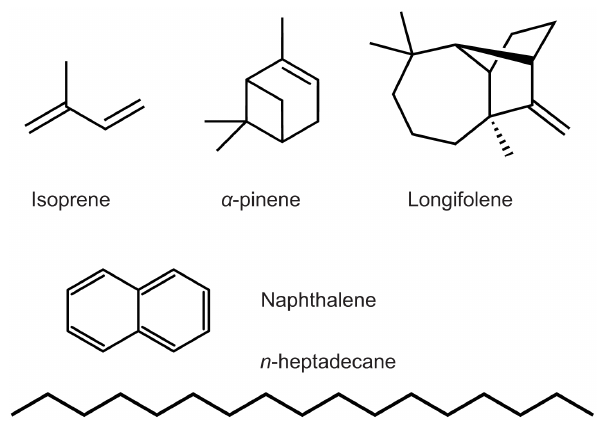
Fig. 1. Molecular structures of the VOC and IVOC gaseous precur- sors used to generate SOA for the experiment: biogenic precursors are in the top row, anthropogenic model precursors are on the bot-